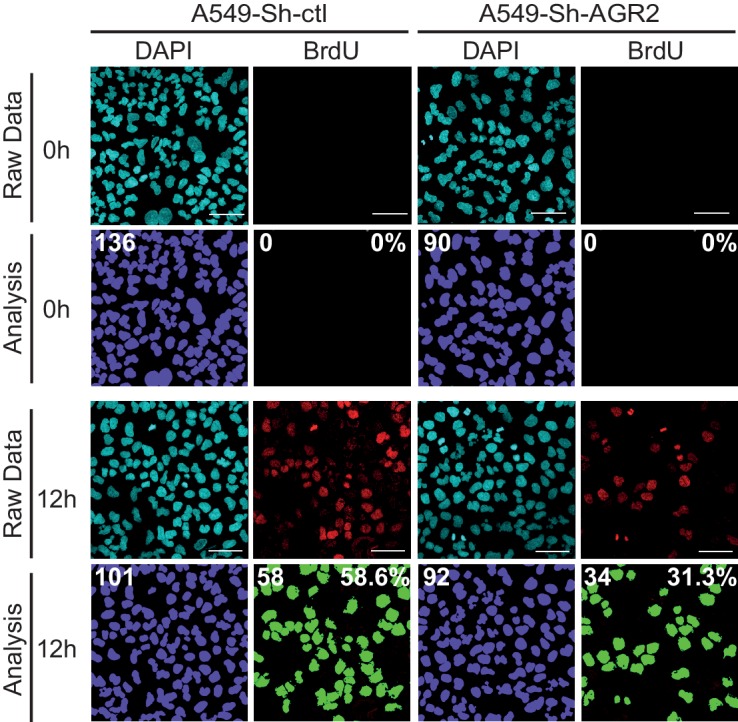
Cell proliferation on A549-Sh-AGR2 depleted cells.Representative images of A549 control cell (Sh-ctl) and A549-Sh-AGR2 depleted cells (Sh-AGR2) stained for BrdU (red) administrated 12 hr before, and with DAPI (blue). Images were subjected to high throughput imaging (bottom panels, analysis data). After acquisition of the dataset, images were segmented by a watershed transformation to identify individual cells (bottom right). Scale bars: 100 μm.